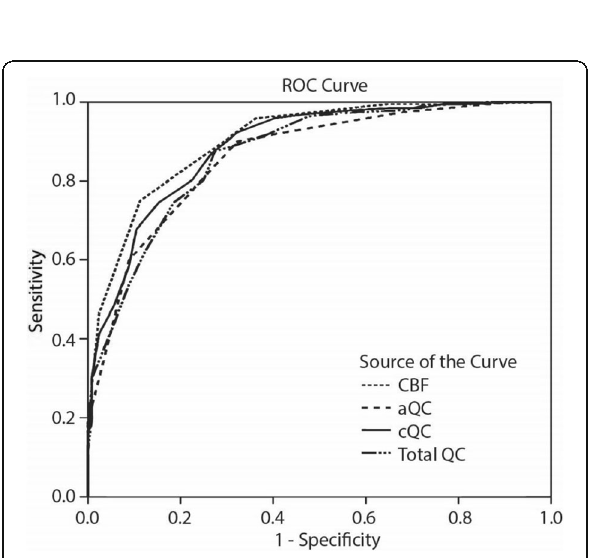
Fig. 5 Receiver-operator characteristic (ROC) curves of cerebral blood flow (CBF) cQC, contrast-based quality control (cQC), artifact- based QC (aQC) and total QC. The areas under the curve for these 4 parameters are, respectively: 0.90, 0.89, 0.87, and